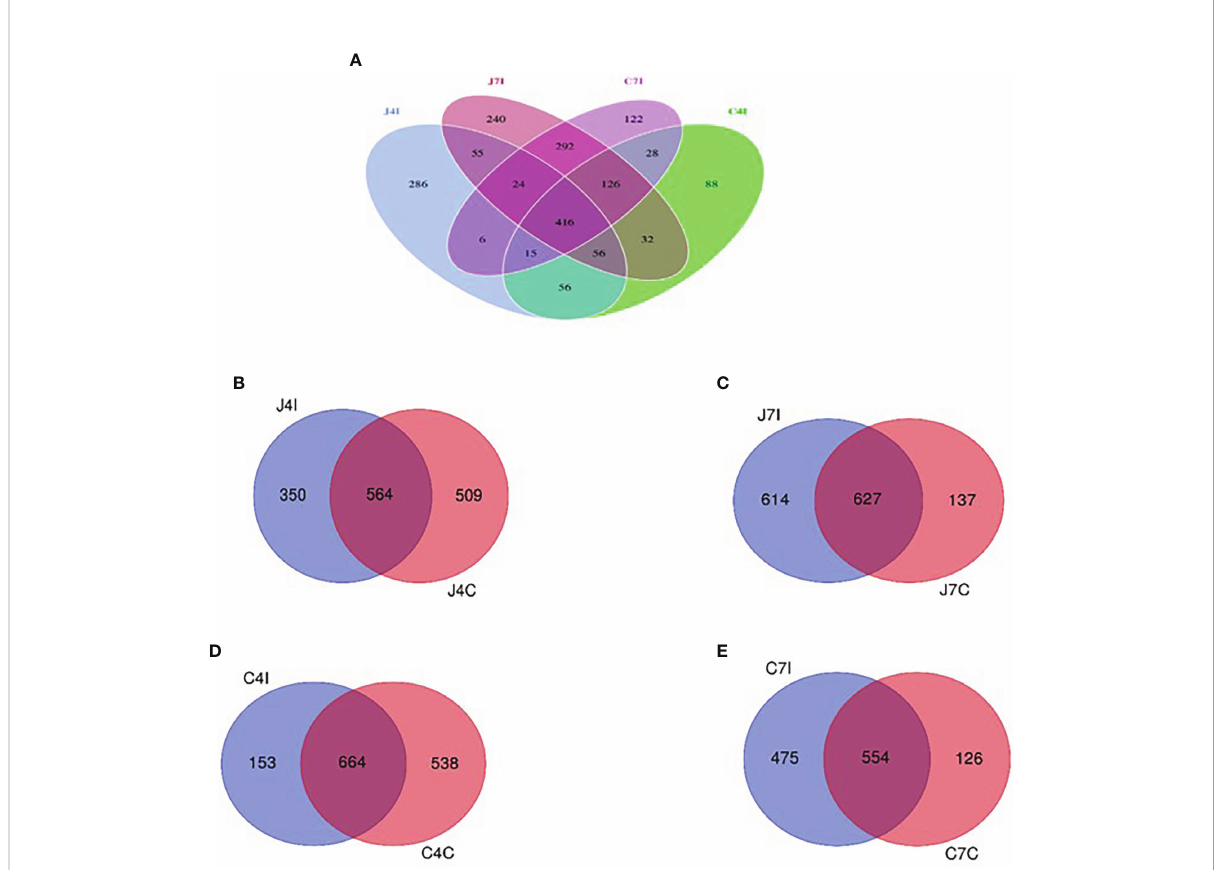
FIGURE 4 Venn diagram showing the number of unique and shared OTUs in jejunum and cecum content microbial. (A) The jejunum and cecum OTUs at fourth- and seventh-day post-infection. (B) OTUs of jejunum at fourth-day post-infection and control group. (C) OTUs of jejunum at seventh- day post-infection and control group. (D) OTUs of cecum on the fourth-day post-infection and control group. (E) OTUs of cecum at seventh- day post-infection and control